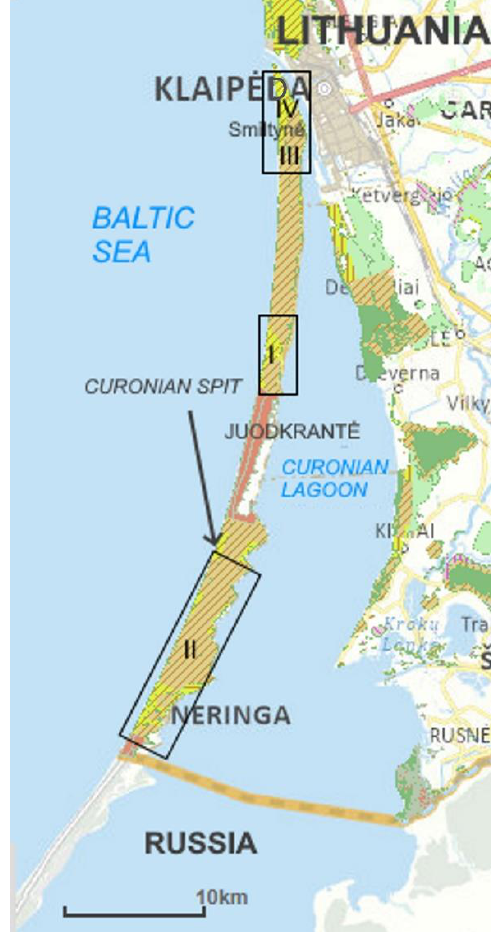
Figure 1. The Curonian Spit. Locations of sampling sites: I-Juodkrante forest enterprise, II-Nida forest enterprise, II-Smiltyne I forest enterprise, IV-Smiltyne II forest enterprise. We used Geoportal.lt (Geoportal.lt, Vilnius, Lithuania) maps.